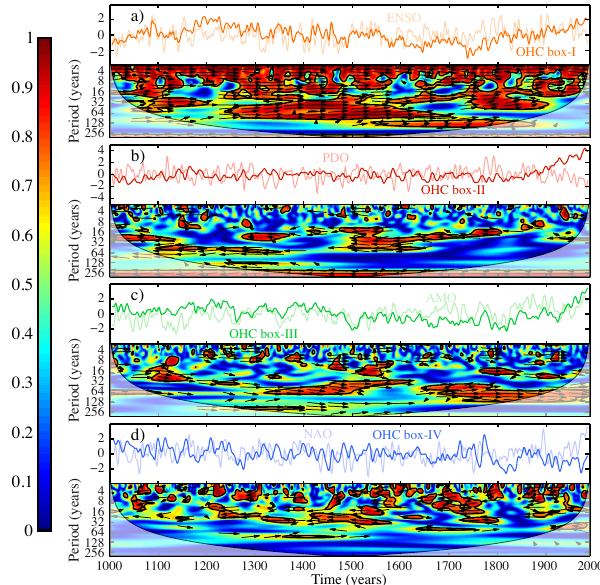
Fig. 15. The same as in Fig. 9 but between the standardised indices of ENSO, PDO, AMO and NAO and the OHC700 averages in the corresponding boxes defined in Fig. 13. In the top panels time se- ries are smoothed with a 10yr low-pass filter to ease comparison at interdecadal